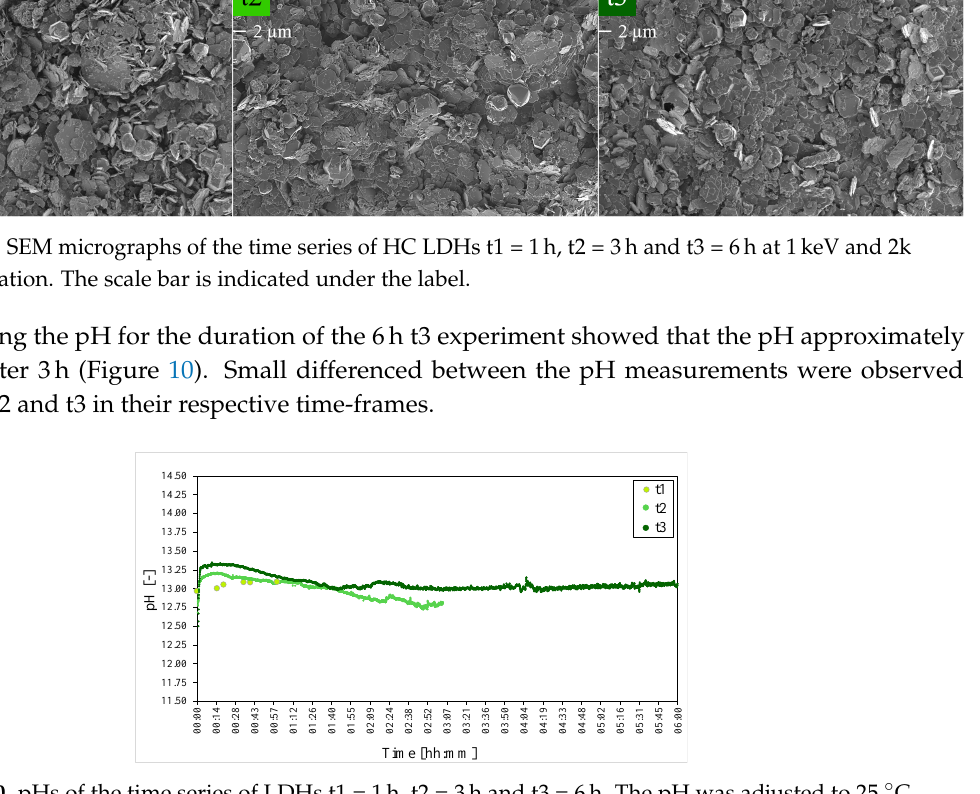
Figure 10. pHs of the time series of LDHs t1 = 1h, t2 = 3h and t3 = 6h. The pH was adjusted to 25 ◦ C to facilitate